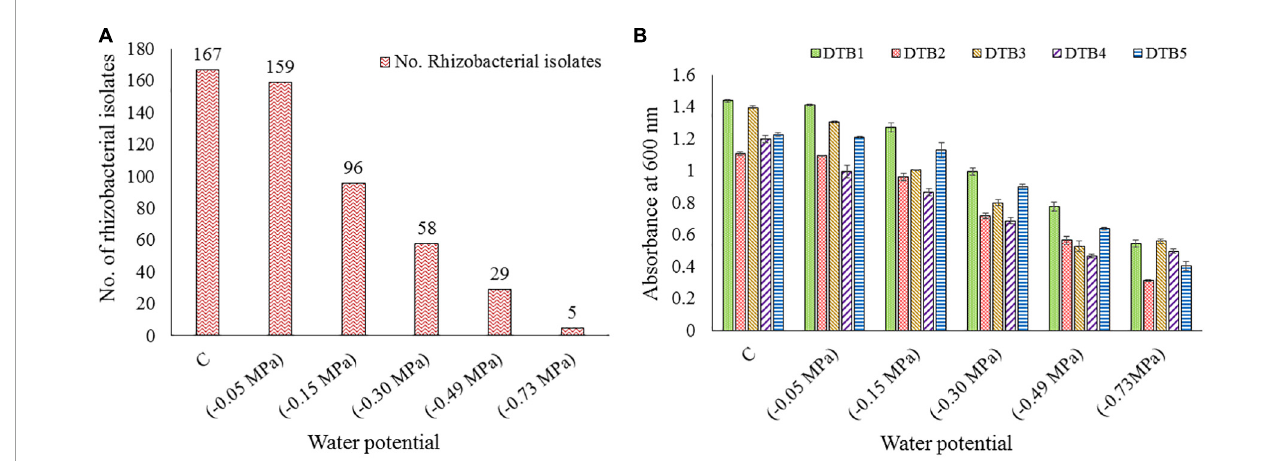
FIGURE1 (A) Total number of different bacterial isolates obtained from various soil samples and further surviving isolate count at various levels of desiccation stress imposed by PEG-6000, (B) growth performance of five selected desiccation-tolerant bacterial isolates at various levels of desiccation stress imposed by